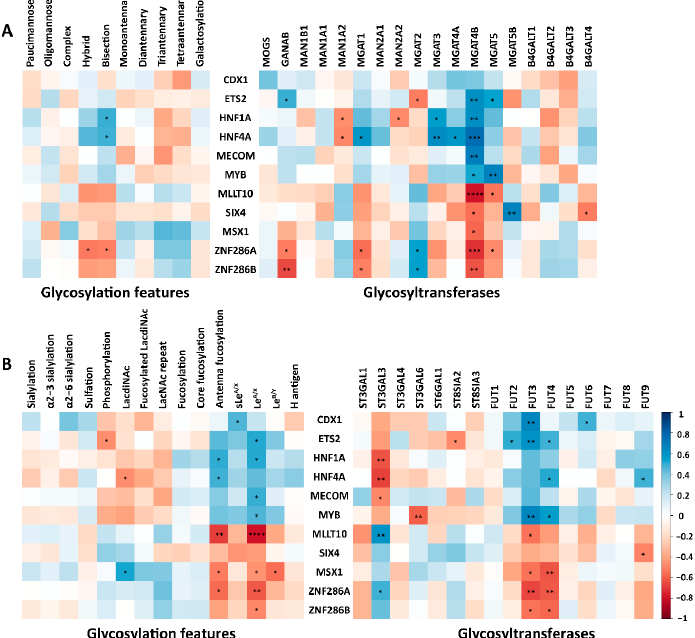
Figure 5. ( A , B ) Associations between transcription factors (TFs) and glycosylation features ( left panel) and GTs ( right panel). The association between abundances of glycosylation features and mRNA expression levels of relevant genes taken from a publicly available dataset [15] was tested using Spearman correlation. Significant values are marked with * ( p ≤ 0.05), ** ( p ≤ 0.01), *** ( p ≤ 0.001), and **** ( p ≤ 0.0001). The correlation coefficient is displayed on the right key bar (blue: positive correlation; red: negative correlation).